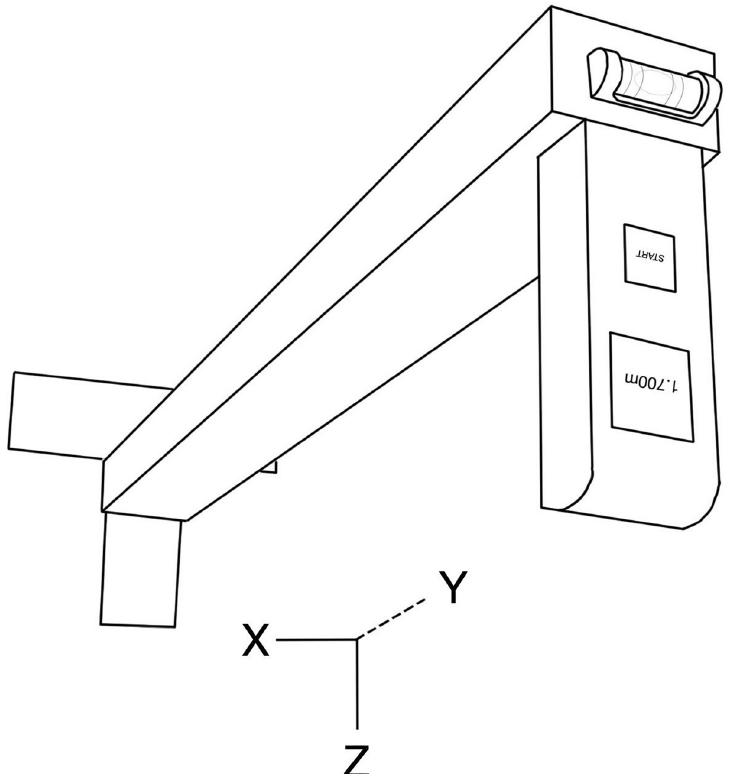
Fig 1. The laser height